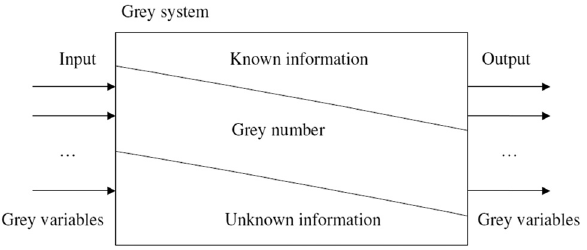
Figure 2: The concept of a grey system [ 37 ] .